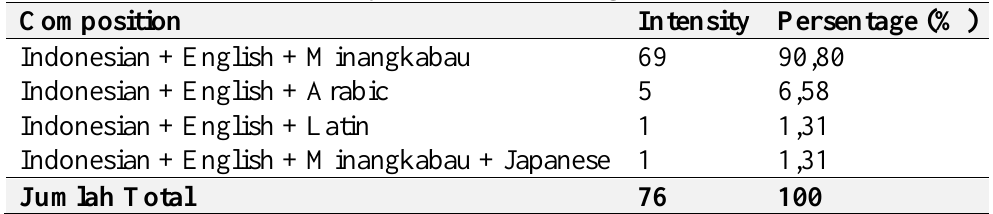
Table 7. Intensity of use of multilingual